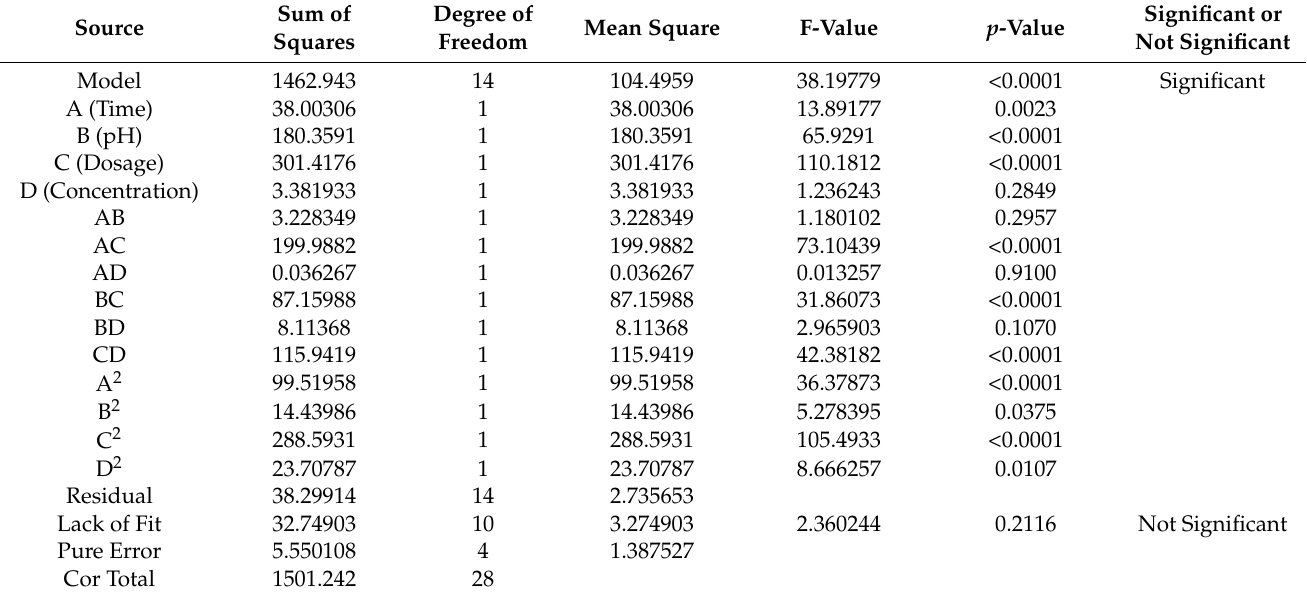
Figure 16 presented the relationship between the probability of normal distribution. The points of the residuals on the plot followed a straight line, which indicated that the model prediction was accurate. Figure 17 showed the comparison of the experimen- tal carmine decontamination percentage with the predicted values obtained from the model, and the value of the determination coefficient (Adj-R 2 = 0.9409) is also presented in Figure 17. Excellent agreement was displayed between the experimental and predicted val- ues of the carmine decontamination percentage. As shown in Figure 18, three-dimensional (3D) and contour (2D) response surface plots present the interaction between the two tested variables and the dye decontamination, while the other variables were kept at